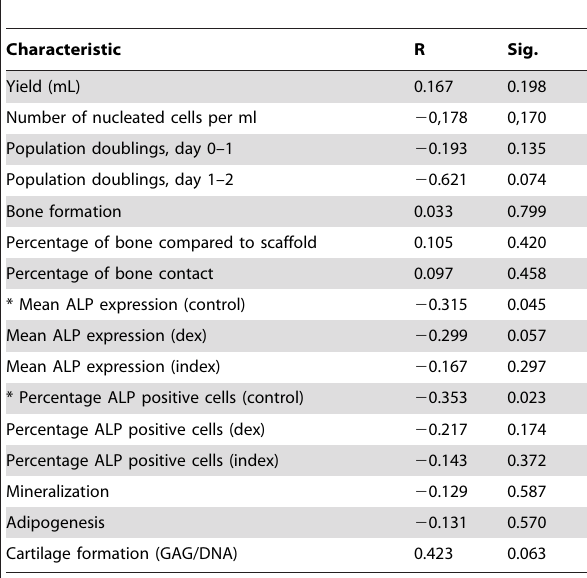
Table 1. Pearson correlation of biological characteristics with donor